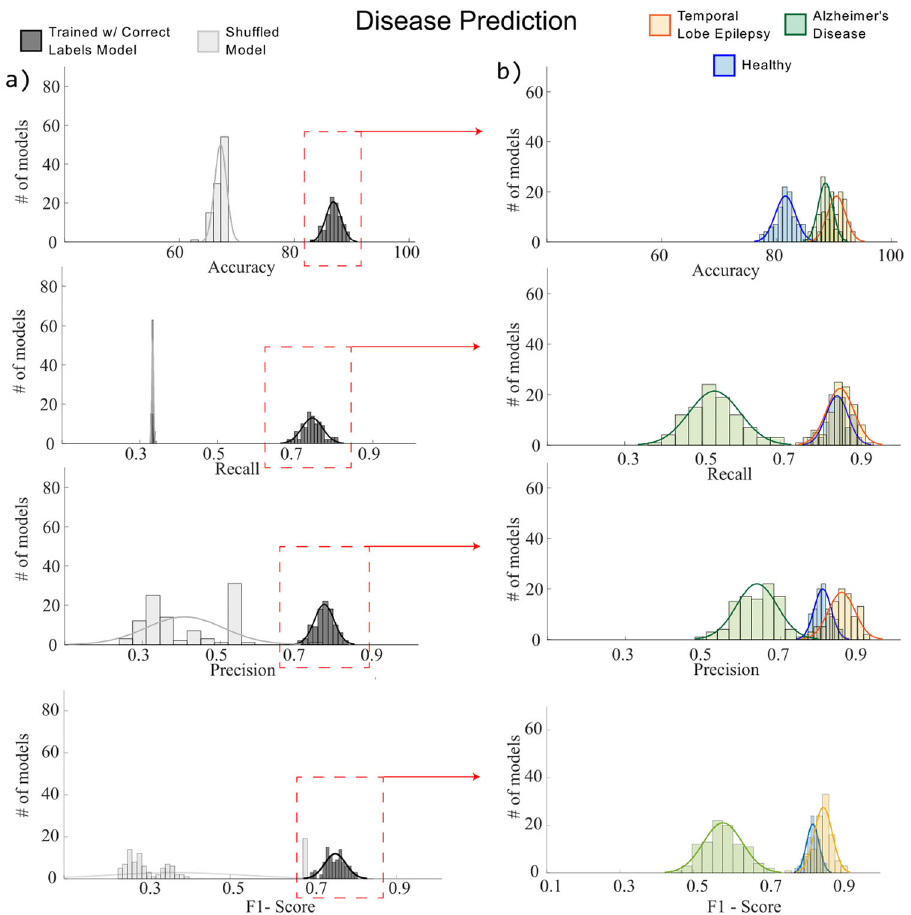
Fig. 5 Model performance for disease prediction. Model performance for disease prediction using our preprocessed brain slices. Column a : Gray bar graphs indicate correct label model performance (darker) and the shuf fl ed models (lighter). Column b : Colored bars indicate disease speci fi c